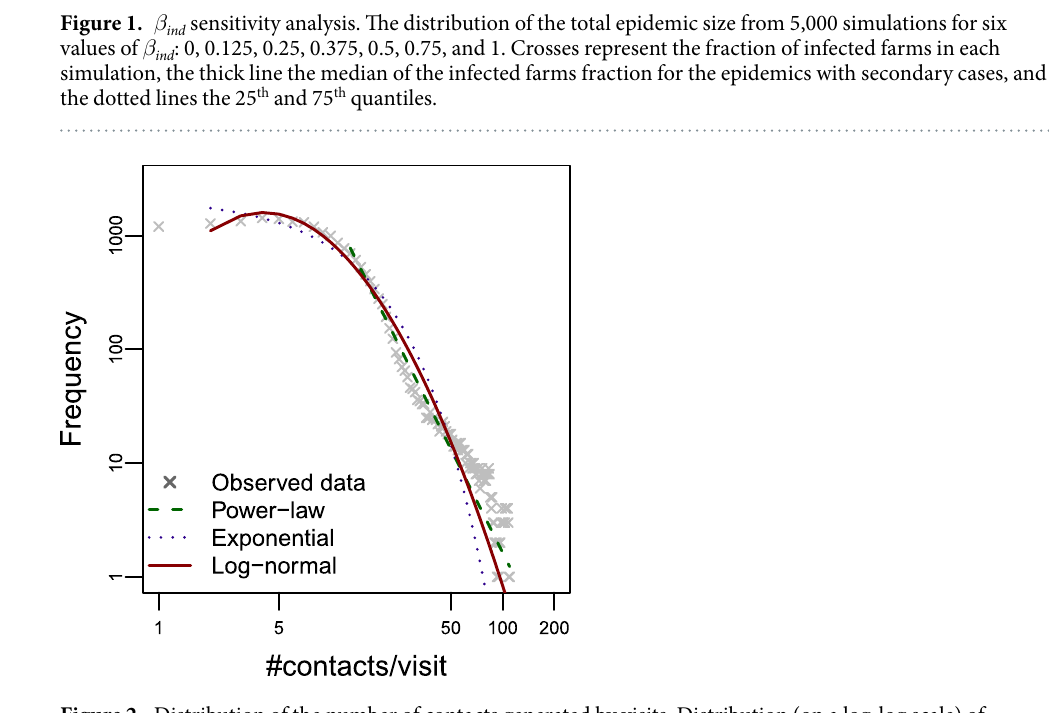
Figure 2. Distribution of the number of contacts generated by visits. Distribution (on a log-log scale) of the number of contacts per visit ( h = 14 days). Crosses represent the observed data, thick line: discrete log- normal fit, dotted line: discrete exponential fit, dashed line: discrete power law fit (distributions fitted using the maximum likelihood estimation 32, 52